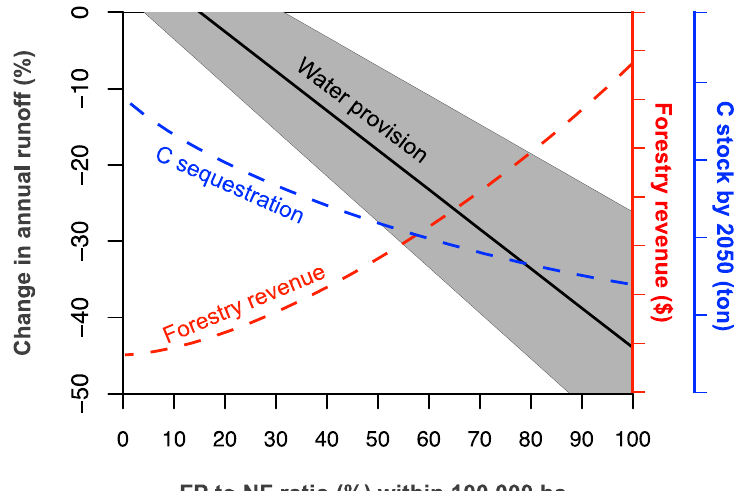
Figure 10. Variation in water supply under different tree cover combinations adopted to fulfill the Chilean NDC afforestation commitment (grey area represents the 25th to 75th percentiles). The dotted lines are hypothetical lines to visualize potential revenues from the forest industry (red line) and potential carbon sequestration by year 2050 from the different types of trees (blue line). Forestry revenues and carbon stock by 2050 are relative values respect to an attainable maximum. The interception between both curves at a given FP to NF ratio is arbitrary.